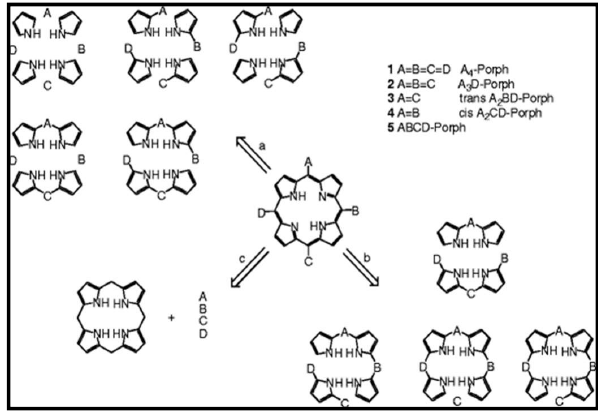
Figure 9. Retro-synthetic pathways to ABCD porphyrins.